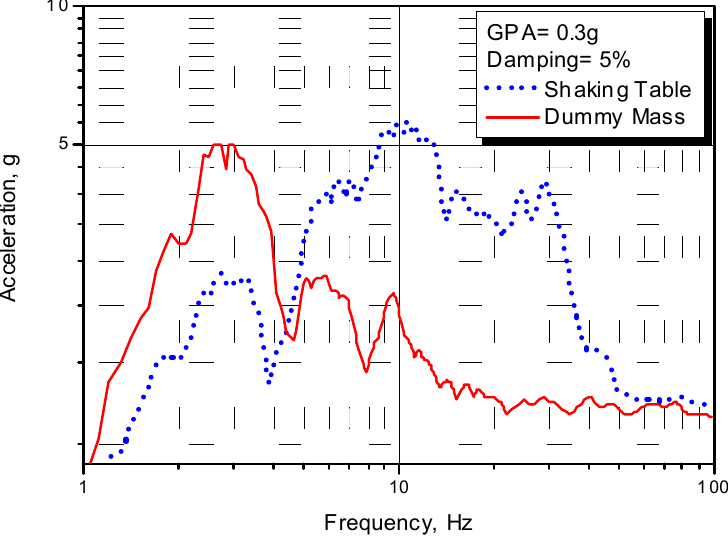
Figure 13. Comparison of test response spectra (SSE, 137 ft).